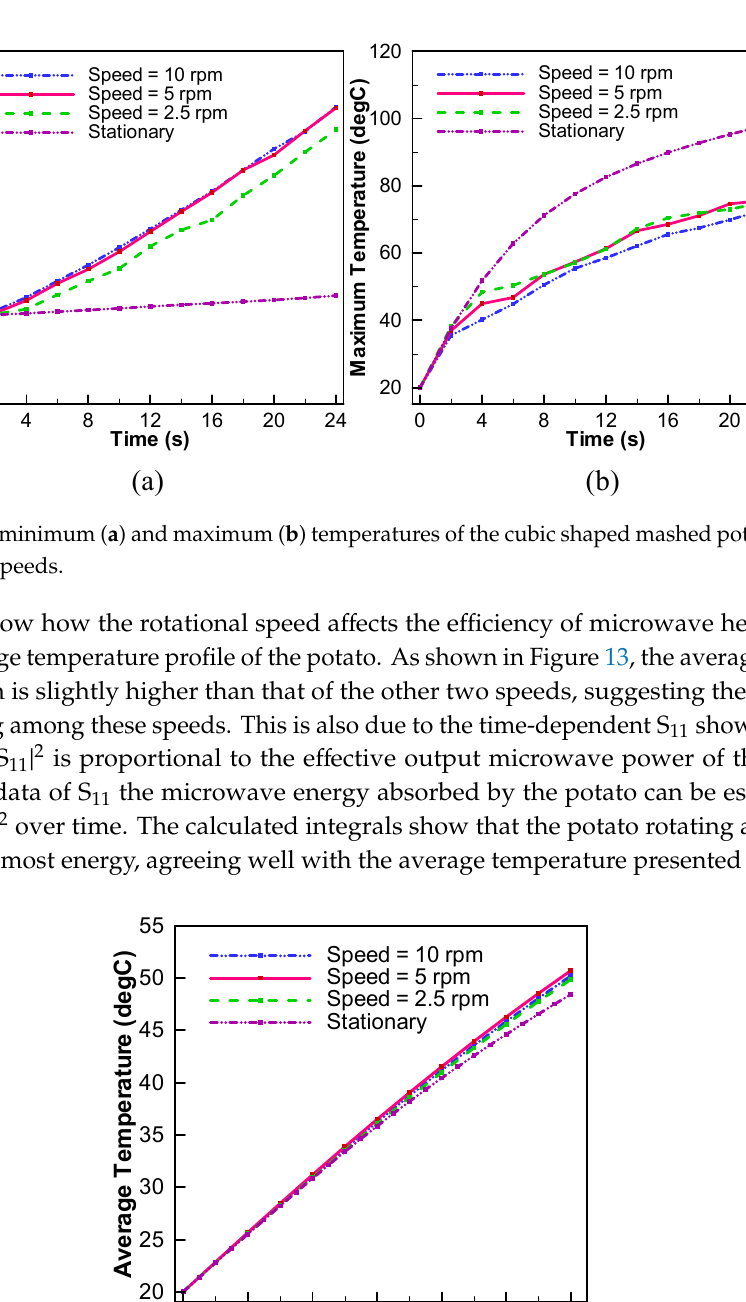
Figure 14. Outline of potato and simulated temperature distributions on the top surface of the cylindrical meshed potato after microwave heating for 24 s with different rotation speeds (top view, unit: ℃ ). Figure 15. The minimum (a), maximum (b) and average (c) temperatures of the cylindrical shaped mashed potato heated with different speeds. 4. Conclusions In this paper, we show a fast, flexible and accurate numerical method to simulate temperature-dependent moving objects coupling the electromagnetic field and thermal field. To avoid the temperature inheritance errors caused by mesh-mismatch, the cavity is rotated in the opposite of the actual rotation direction. More importantly, the dielectric properties of the potato are